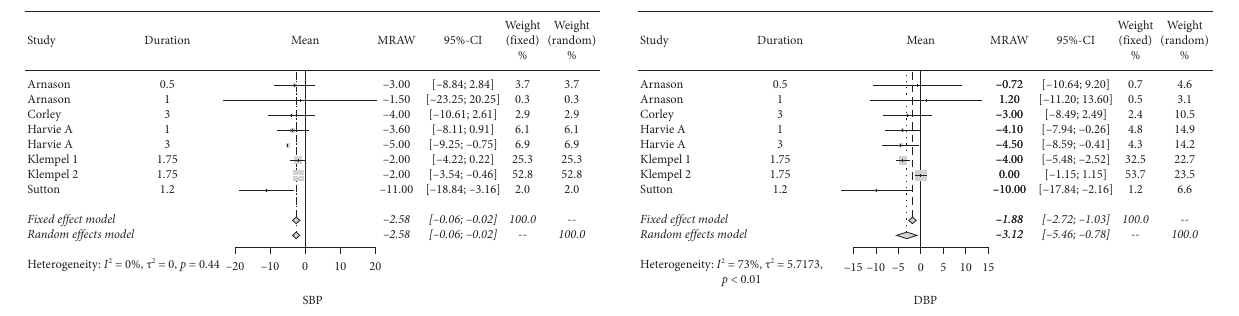
Figure 5: Forest plots for blood